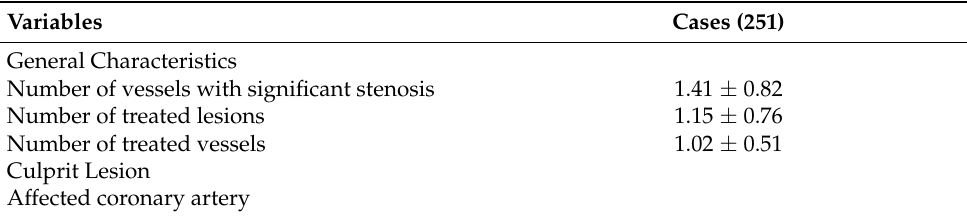
Table A1. Angiographic characteristics of patients with